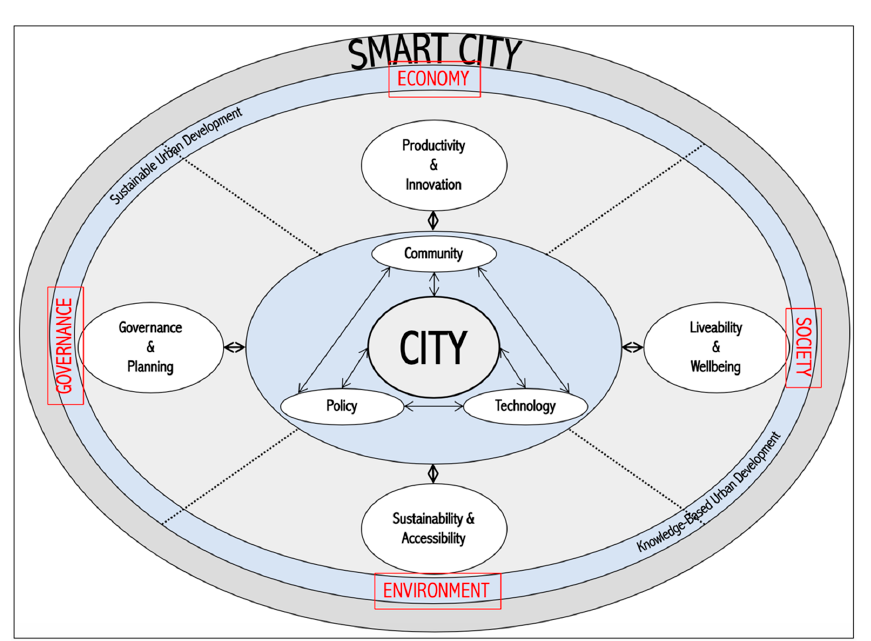
Figure 3. Smart city conceptual framework highlighting key domains, derived from [62].